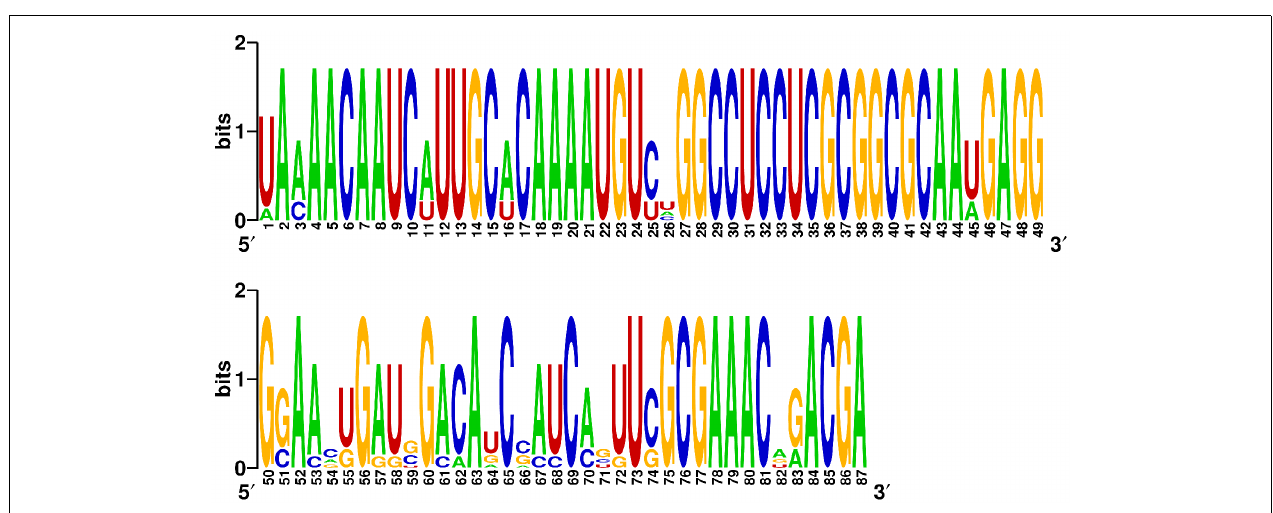
FIGURE 6 |The sequence logo for the eight designed HDV ribozyme sequences. The sequence logo was generated byWebLogo (Crooks et al., 2004).